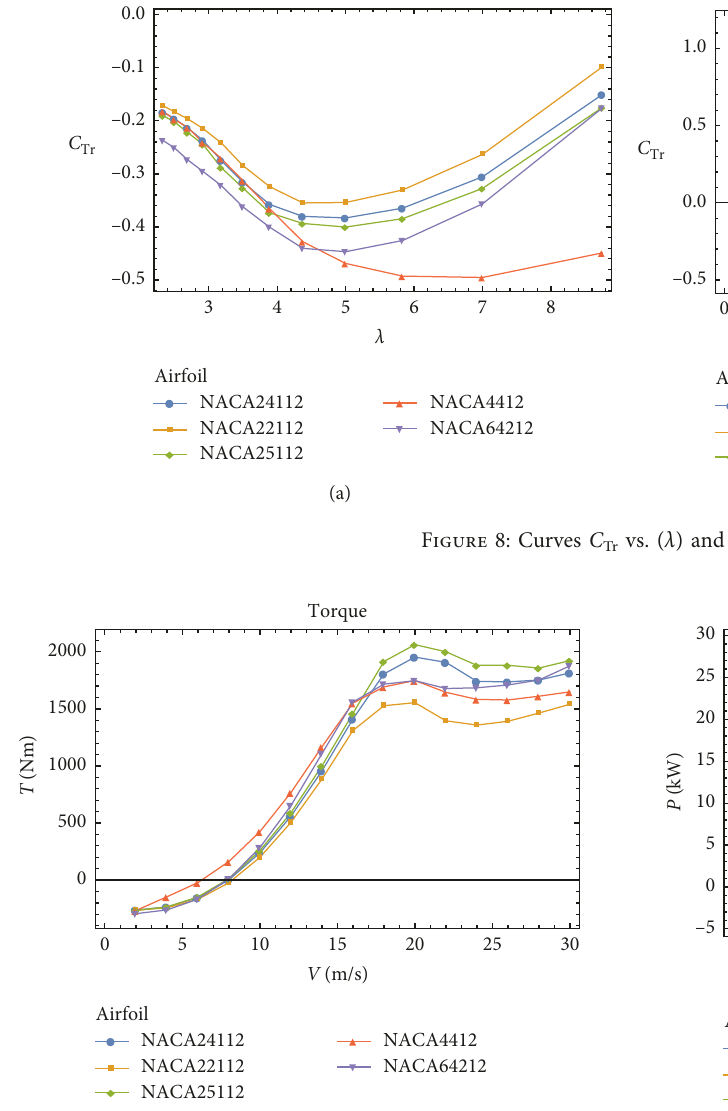
Figure 9: Torque evaluation of NACA profiles at different wind